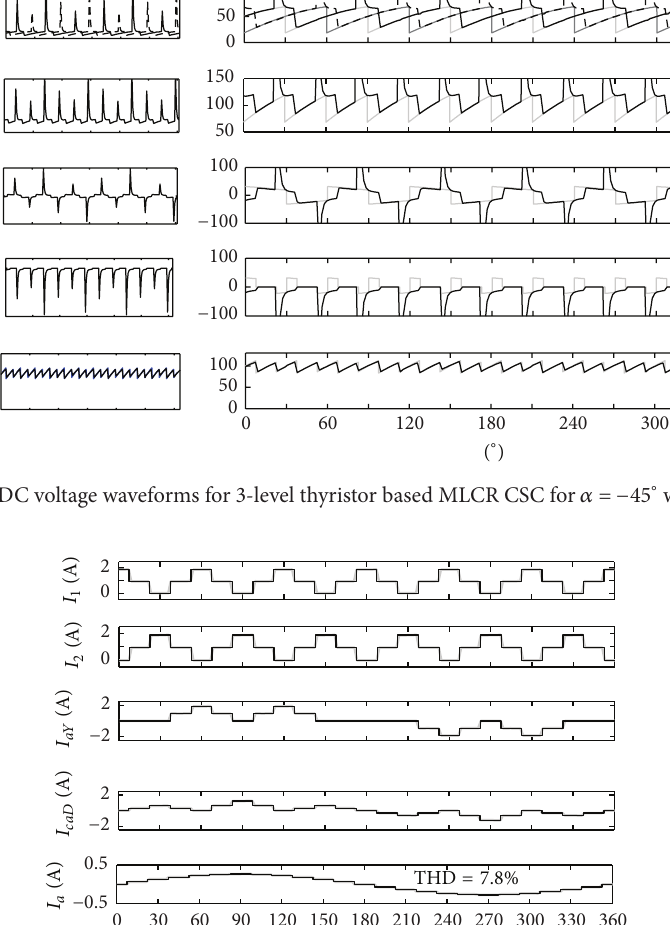
time. A “normal” snubber is defined as the one which allows the current to reach the rated level at the same time the voltage reaches zero. A small snubber allows the current to rise faster while a large snubber slows the current rise